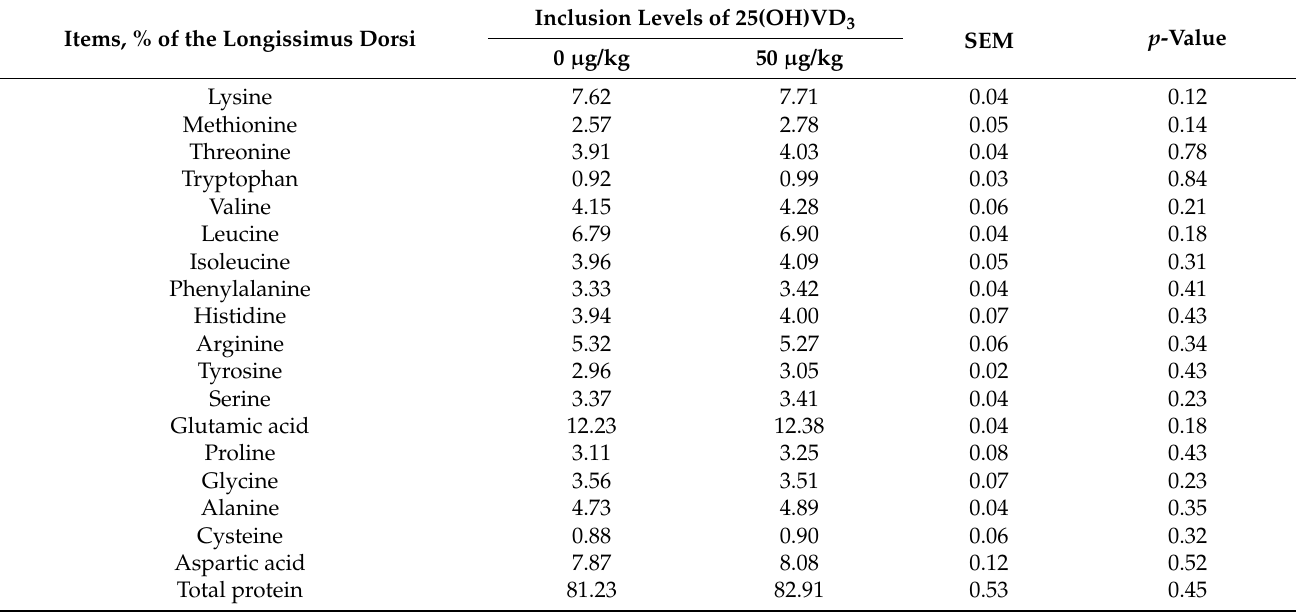
Table 5. Effects of dietary addition of 0 and 50 µ g/kg 25(OH)VD 3 on amino acid composition in the longissimus dorsi of growing-finishing